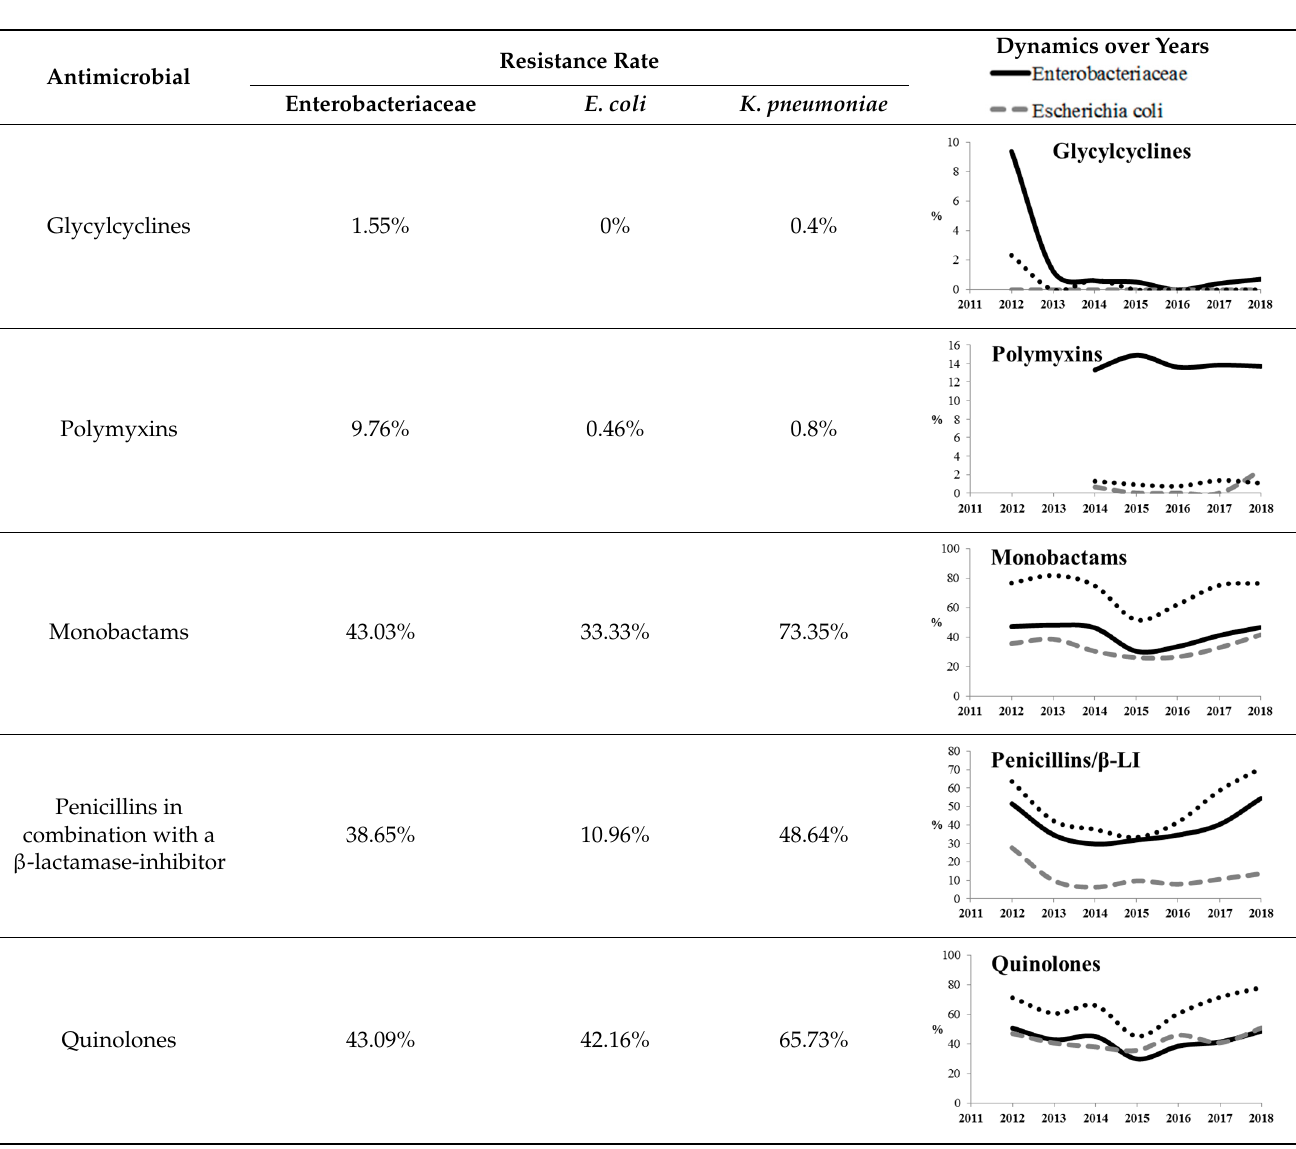
Table 5. The dynamics of the resistance rates of Enterobacterales , E. с oli, and K. pneumoniae isolates to different classes of antimicrobial Table 5. Cont.